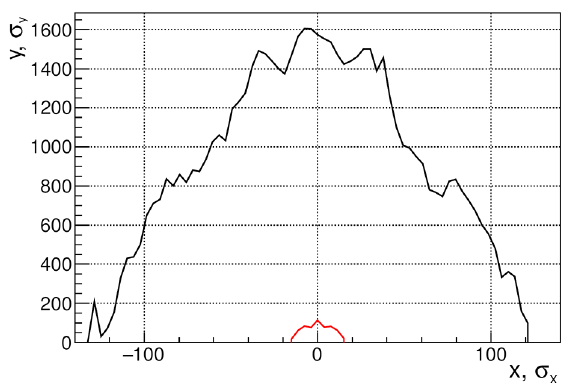
FIG. 14. Dynamic aperture degradation for FCC-ee interaction region variant 2, black is with crab sextupole OFF, red with crab sextupole ON, includes only nonlinearities of the interaction region, on momentum